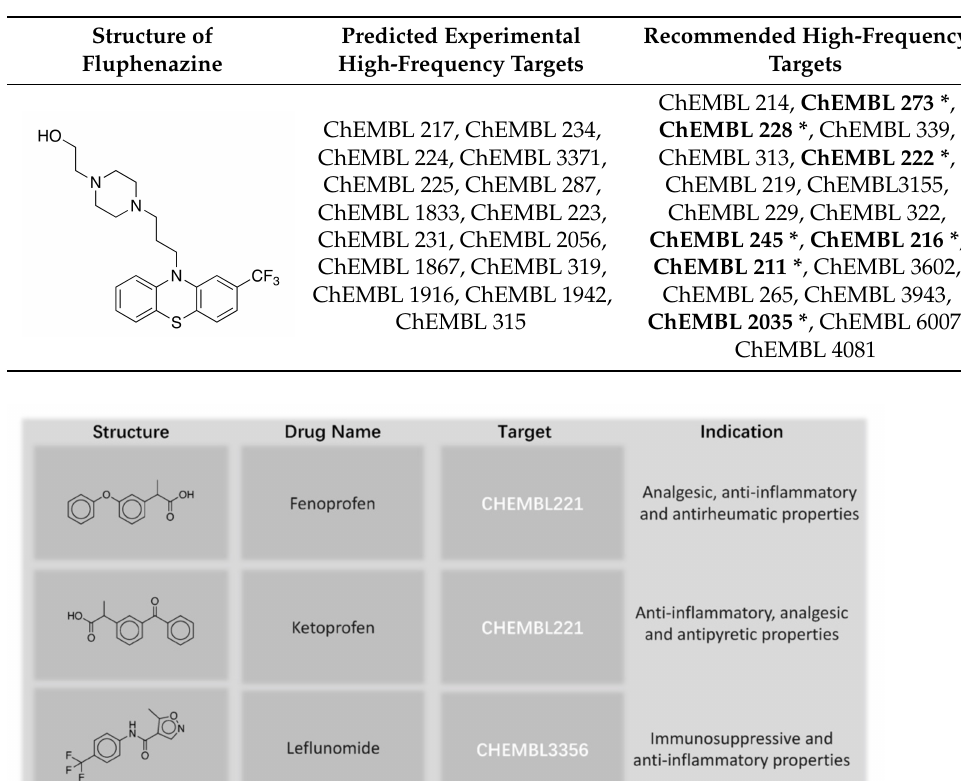
Table 4. Structure and targets of fluphenazine. The potential targets that appear in interactions weaker than our data cleaning standards are marked with asterisks (*) and bolded.